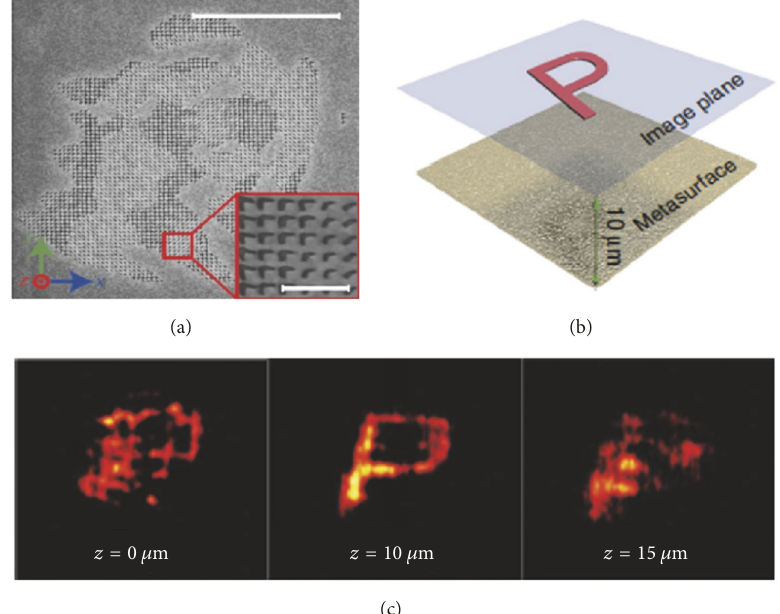
Figure 7: (a) Place a pattern on a specific distance from the metasurface holographic plate (here we choose ten microns). (b) Create a specific holographic template on the metasurface. (c) Metasurface holograms received at a particular